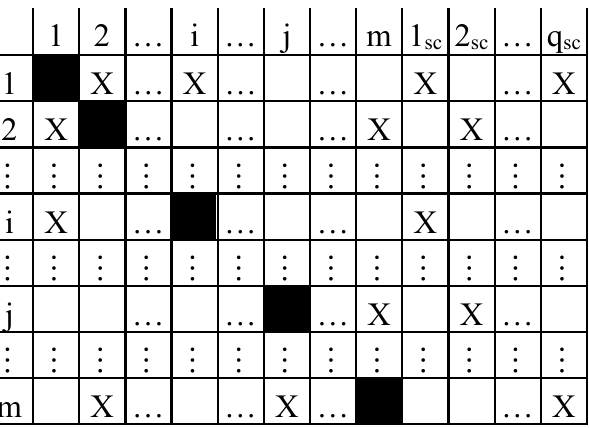
the “table” shown in Figure 4, and a filling procedure for the proposed “table”, which identifies both the sequence S 0 in the case of not-indeterminate PMs and the alternative algorithm to use for indeterminate PMs. Such a general technique is illustrated below.